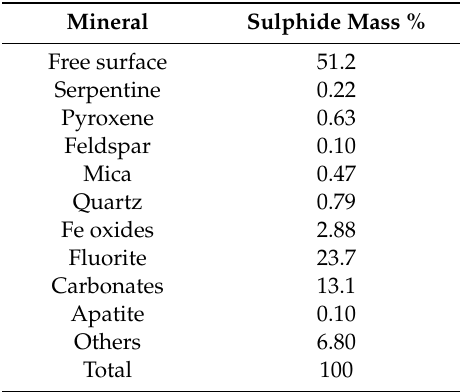
Table 9. Fluorite concentrate sulphide mineral association in mass %.